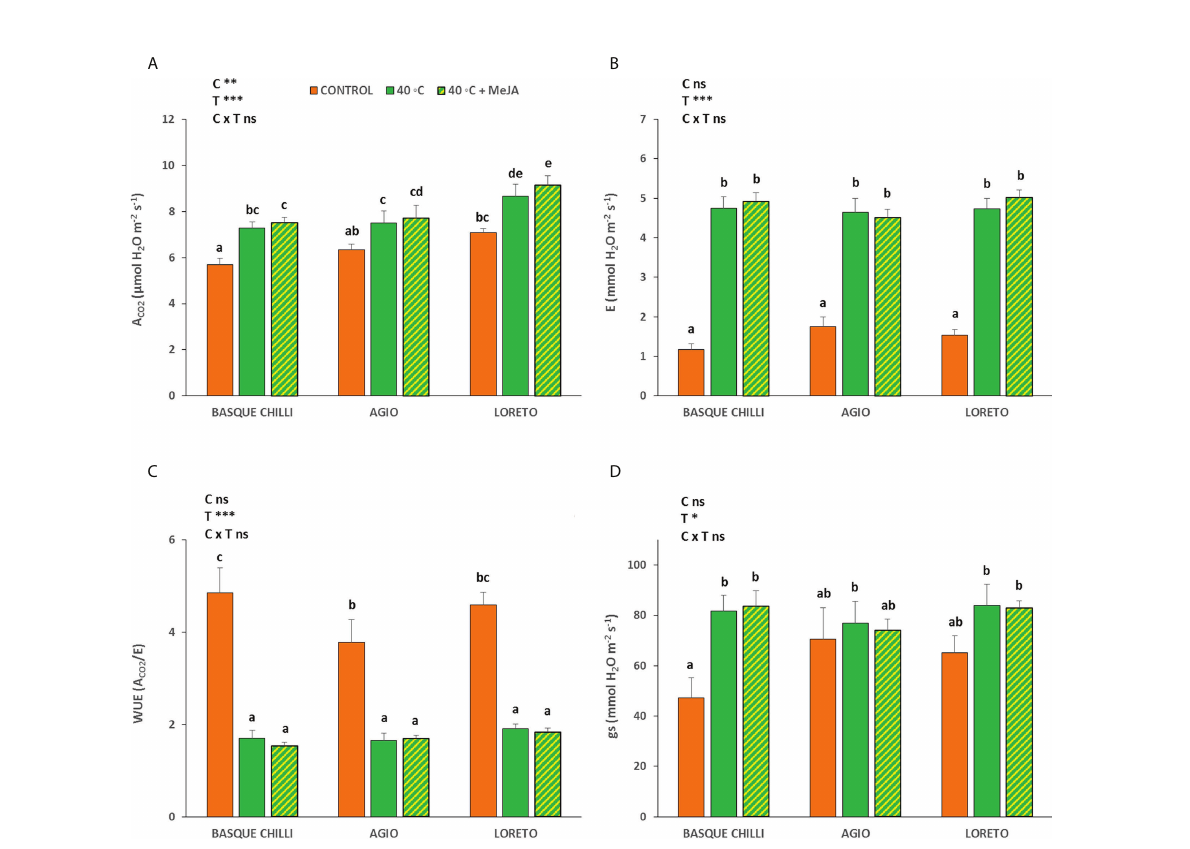
FIGURE 1 Effects of heat shock and MeJA on (A) the net CO 2 assimilation rate (A CO2 ), (B) transpiration (E), (C) stomatal conductance (gs), and (D) intrinsic water use ef fi ciency (WUE) in leaves of the three pepper cultivars. Values are means ± SE. Different letters indicate signi fi cant differences between treatments according to Duncan ’ s test at the 95% con fi dence level. The * refers to signi fi cant differences at the level of p ≤ 0.05; **p ≤ 0.005; ***p ≤ 0.001; n.s., not signi fi cant. C is cultivar; T is